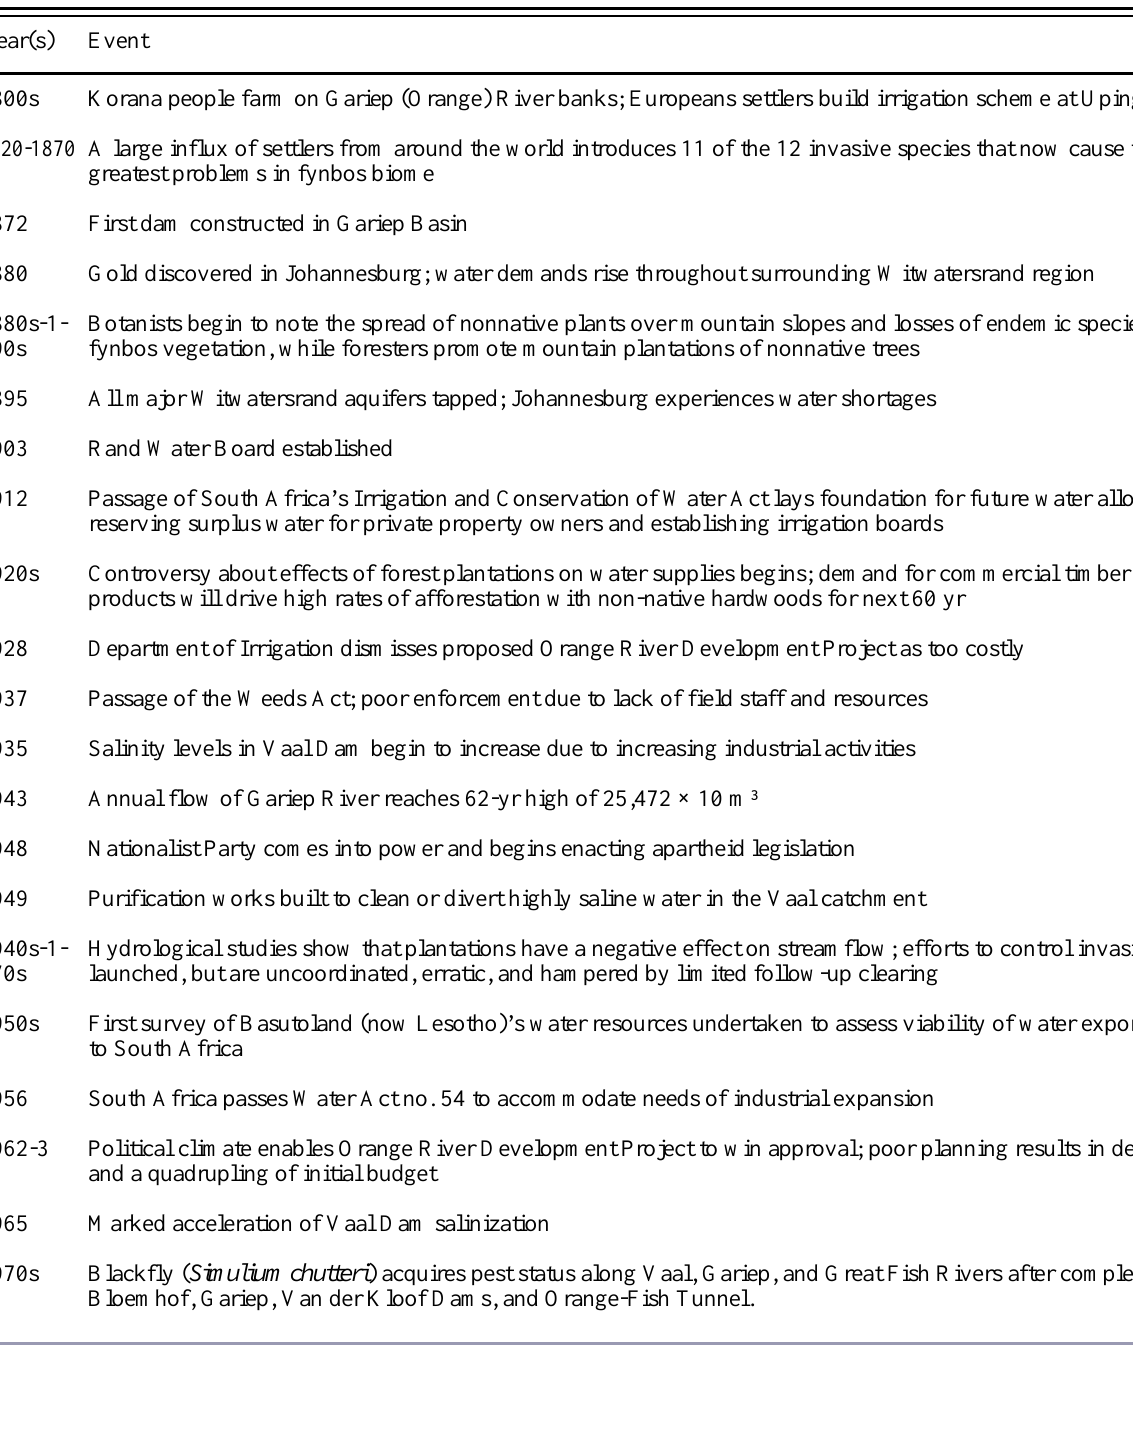
Table 1. Water management in South Africa: a timeline of events. Sources: Herold et al. 1992, Chutter et al. 1996, World Commission on Dams 2000, World Resources Institute (WRI) 2000, Thompson et al. 2001, Turton and Meissner 2003, DWAF 2003, Metsi Consultants 2002, Myburgh and Nevill 2003. Flow is based on annual flow records from 1935–1997; mean flow for period was 6980 ×10 6 m 3